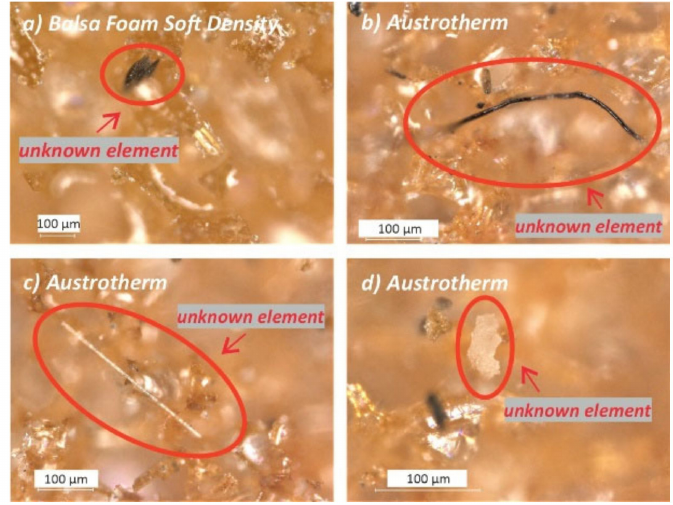
Figure 3. Photomicrographs of some unknown elements observed in the “Unaged” Balsa foam soft density ( a ) and in Austrotherm ( b – d ) foams by a digital microscope with reflected light.